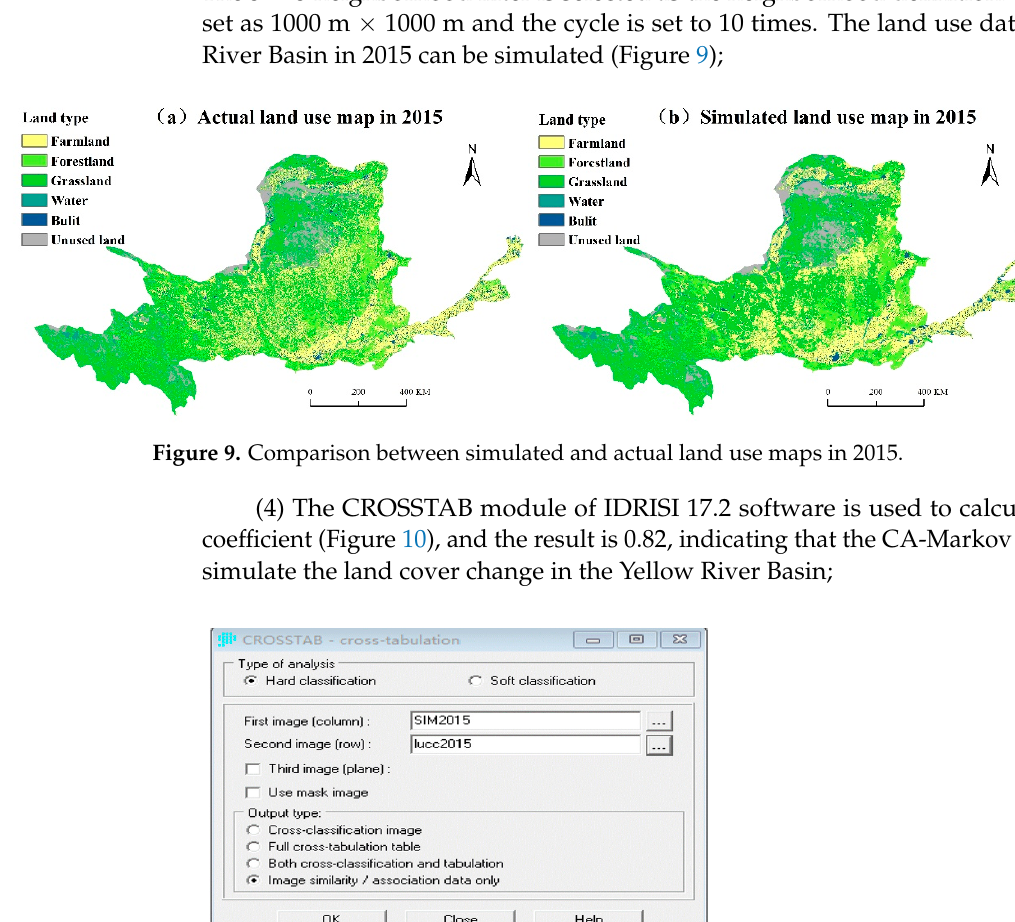
Figure 8. Suitability maps of farmland ( a ), forestland ( b ), grassland ( c ), water ( d ), built land ( e ) and unused land ( f ).